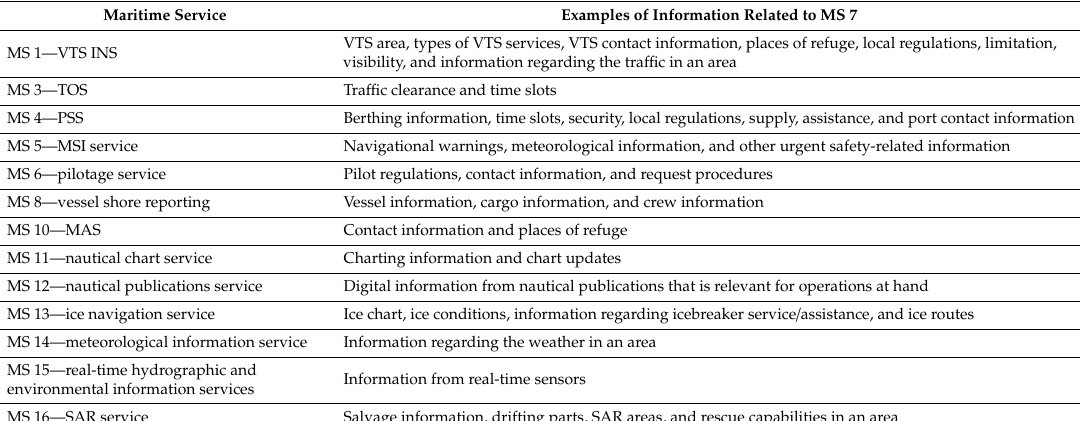
Table 6. Relation to other maritime services